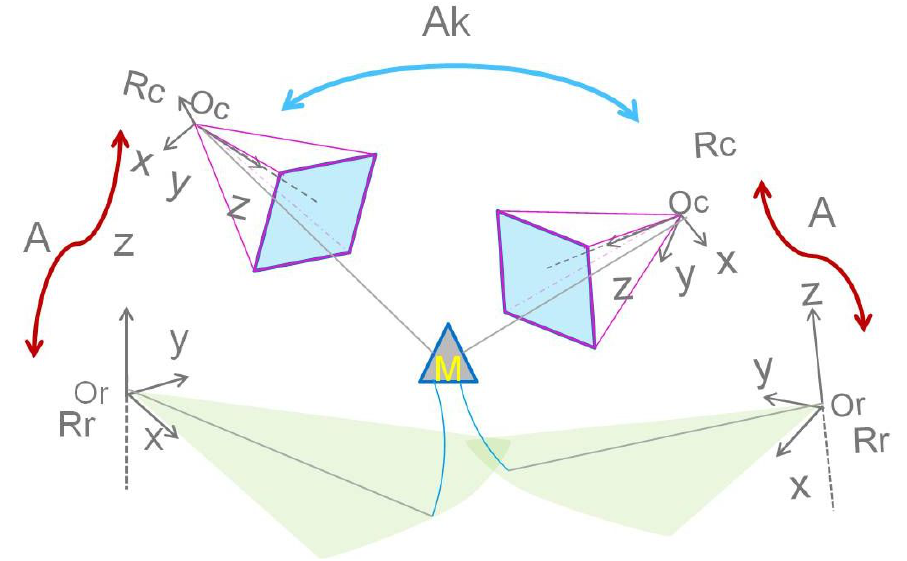
The displacement of the system around a fixed scene gives more geometric equations. An illustration of this process is shown. The matrix A transformation between one position and